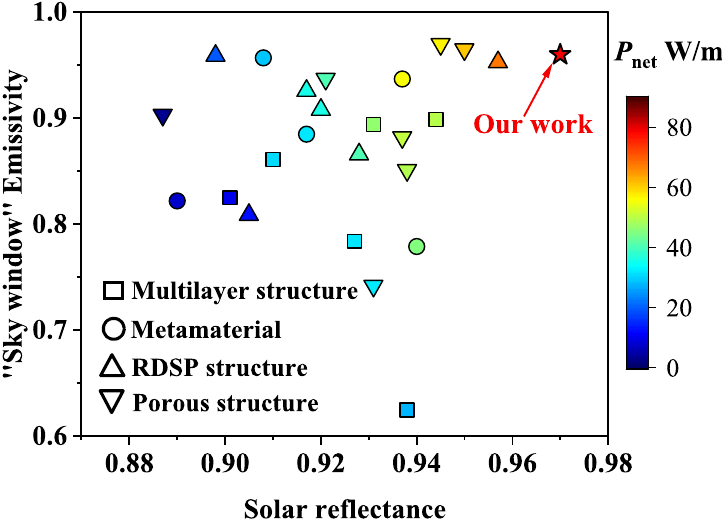
Figure 6. Color map of cooling performance for different PDRC